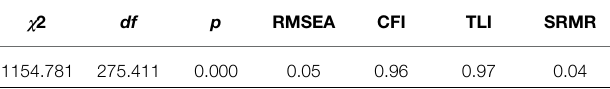
TABLE 2 | Confirmation of the model fitness.